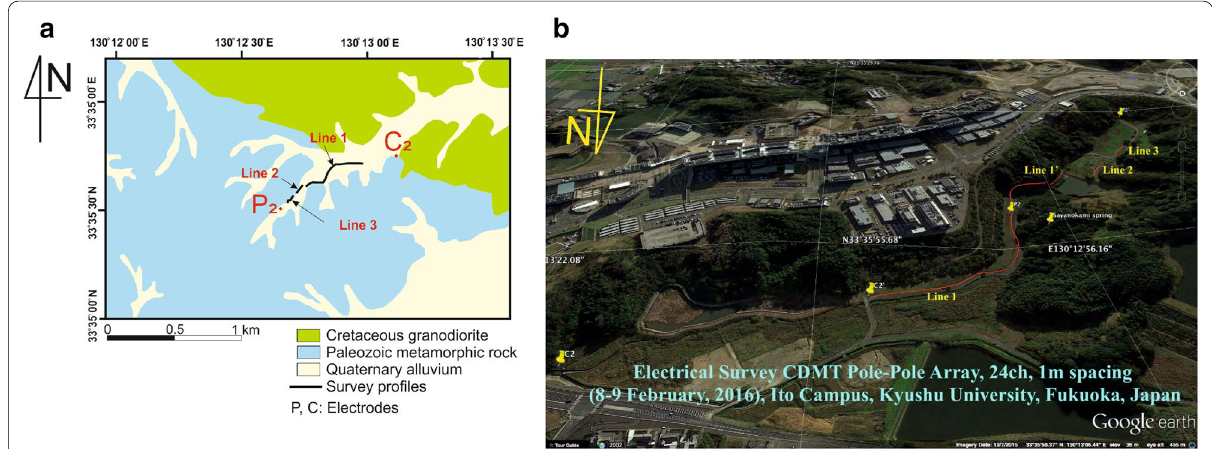
Fig. 2 a Geological map of the study area and locations of the electrical survey lines (Lines 1–3). b Google Earth map showing the locations of the electrical resistivity lines on the Ito campus (Kyushu University, Fukuoka, Japan)